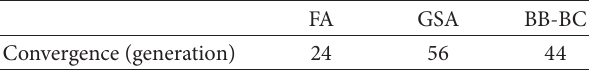
Table 7: Average convergence